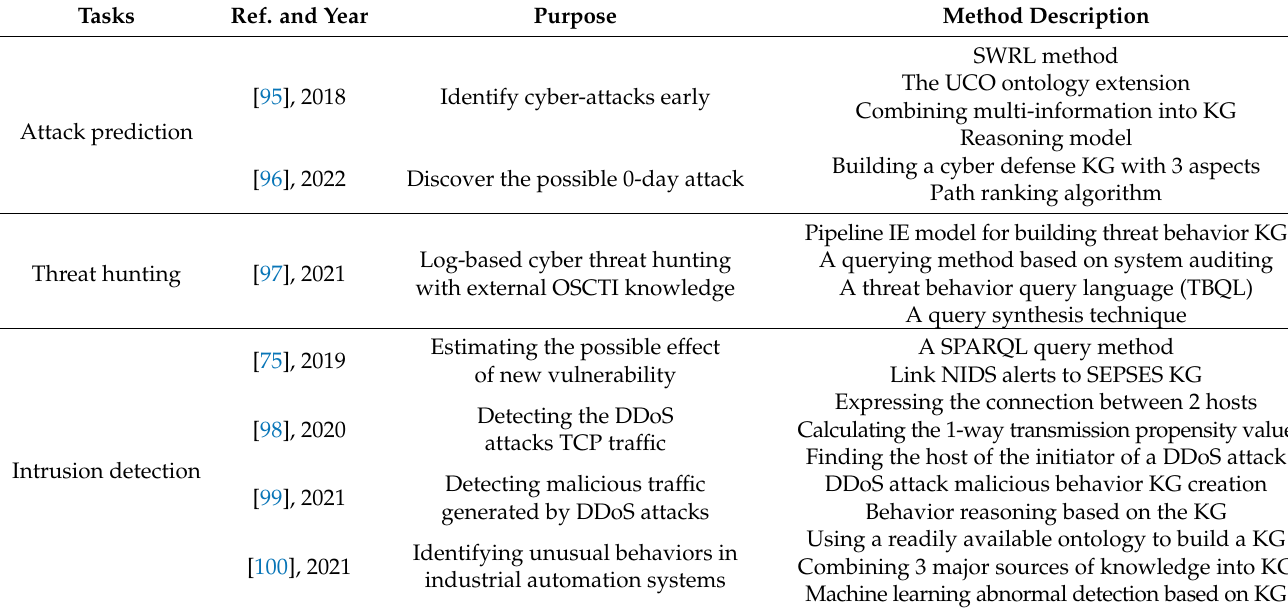
Table 4. The knowledge graph’s application in threat discovery